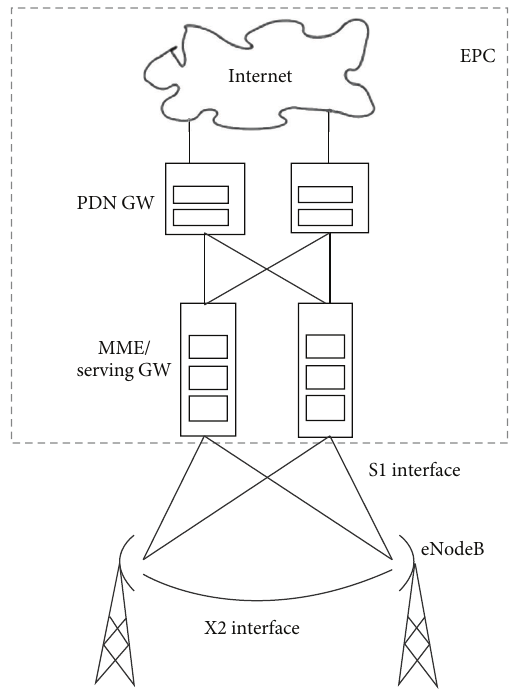
Figure 1: Network architecture of LTE-A